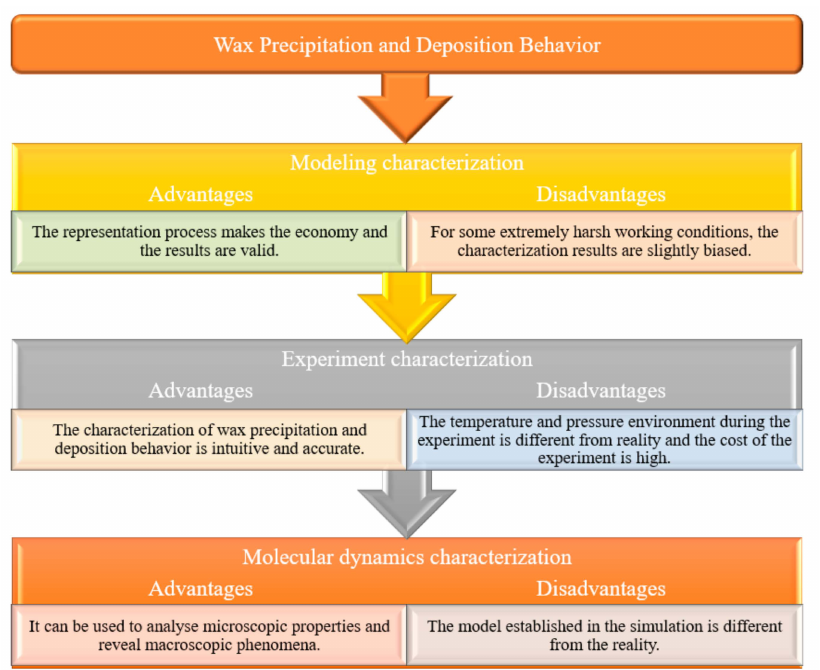
Figure 14. Analysis of wax precipitation and deposition behavior characterization